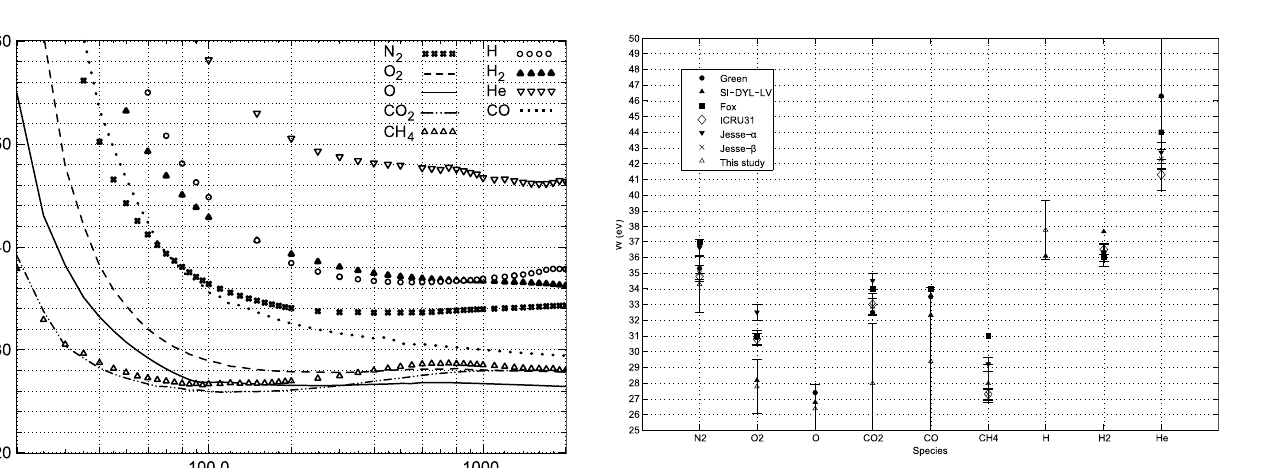
Fig. 4. W values from Table 1 for N 2 , O 2 , O, CO 2 , CO, CH 4 , H, H 2 and He. Error bars are displayed for IRCU data (standard deviation of all experimental records), Jesse and Sadaukis (1957) (1.5%) and our study (cross section uncertainties). Discrepancies are seen between experimental and modelling efforts when there is a lack of accurate and complete cross section data set. This is the case for CO 2 , O 2 and CO (never measured in laboratory), despite the use in this case of the most up-to-date cross sections available in the literature. Since Mars and Venus are mainly composed of these two species, a specific effort from experimentalists is strongly